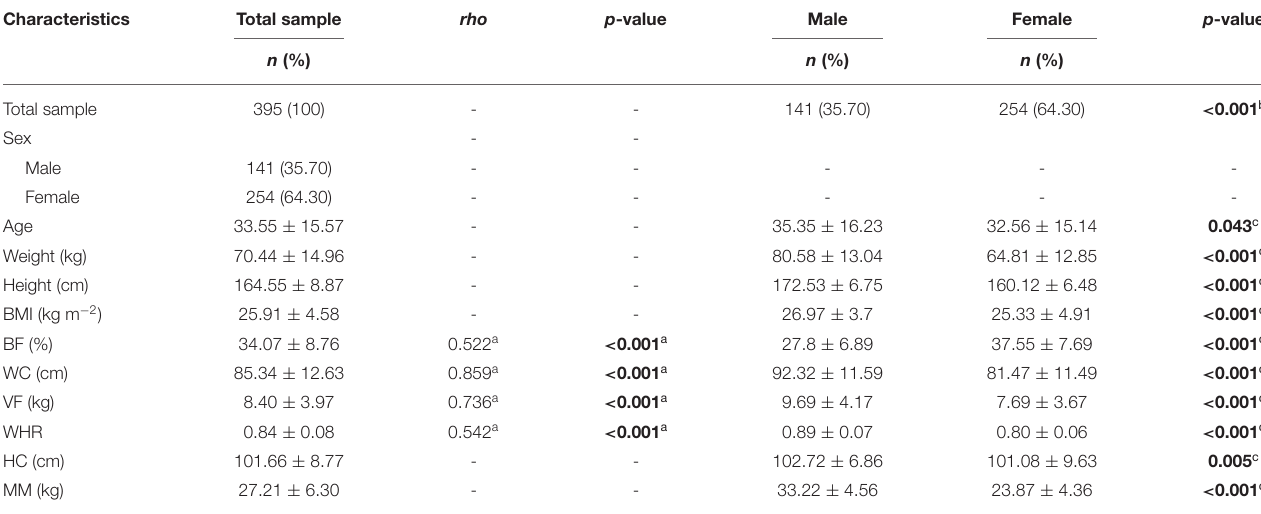
BMI, Body mass index; BF, body fat percentage; WC, waist circumference; VF, visceral fat; WHR, waist-hip ratio; HC, Hip’s circumference; MM, muscle mass. Adiposity indicators: BF, WC, VF, WHR regarding BMI. a Spearman correlation test between BMI and adiposity indicators. b Chi-squared